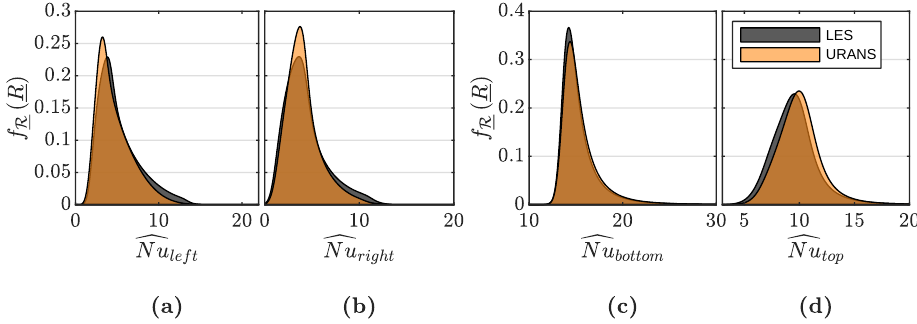
Figure 14. Probability density functions for the mean absolute deviation to the reference case of the Nusselt number: ( a ) on the left wall, (cid:99) Nu left ; ( b ) on the right wall, (cid:99) Nu right ; ( c ) on the bottom wall, (cid:99) Nu bottom ; and ( d ) on the top wall, (cid:99) Nu top